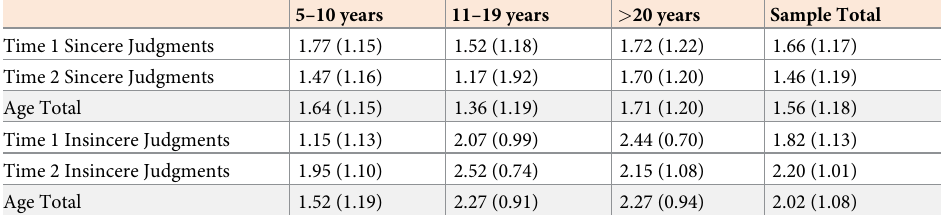
Table 4. Mean (SD) correct judgments of either “mean” or “not mean” to the sincere/benign and insincere/hostile vignettes across age groups.